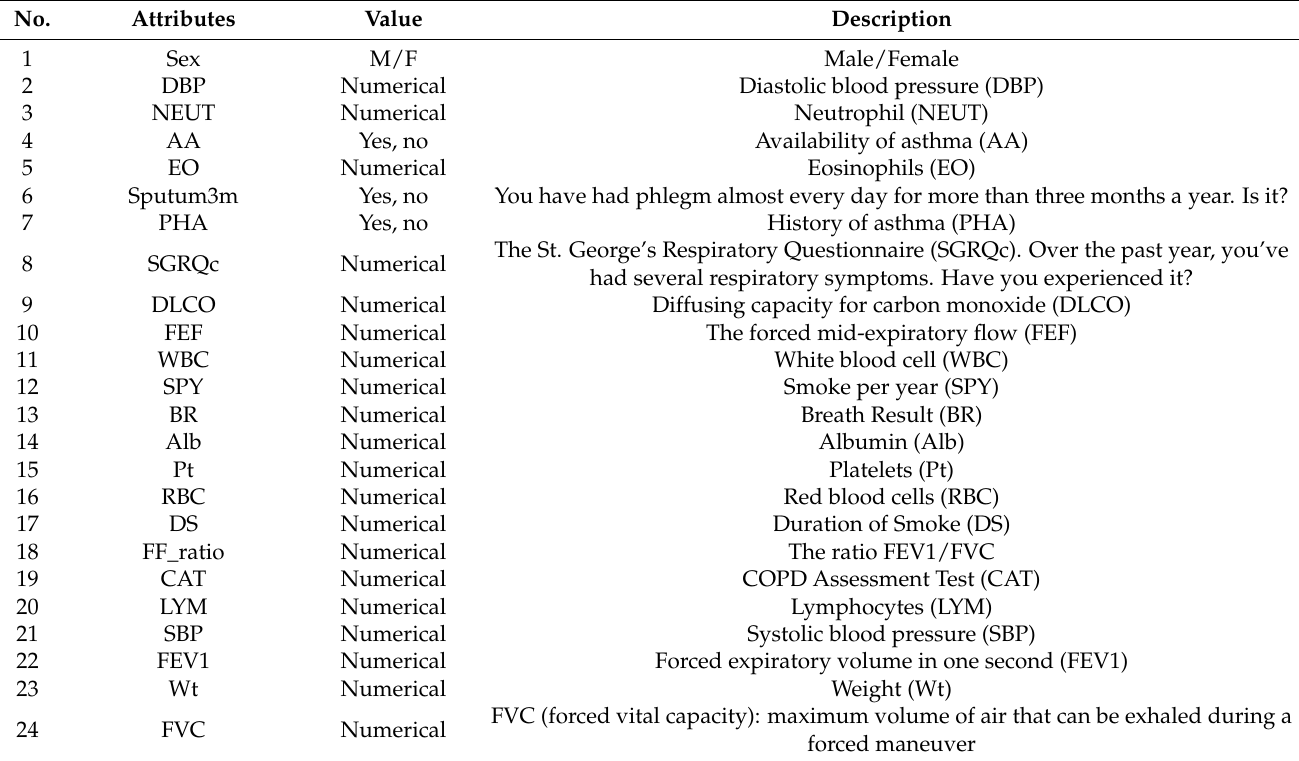
Table 2. Features used in our